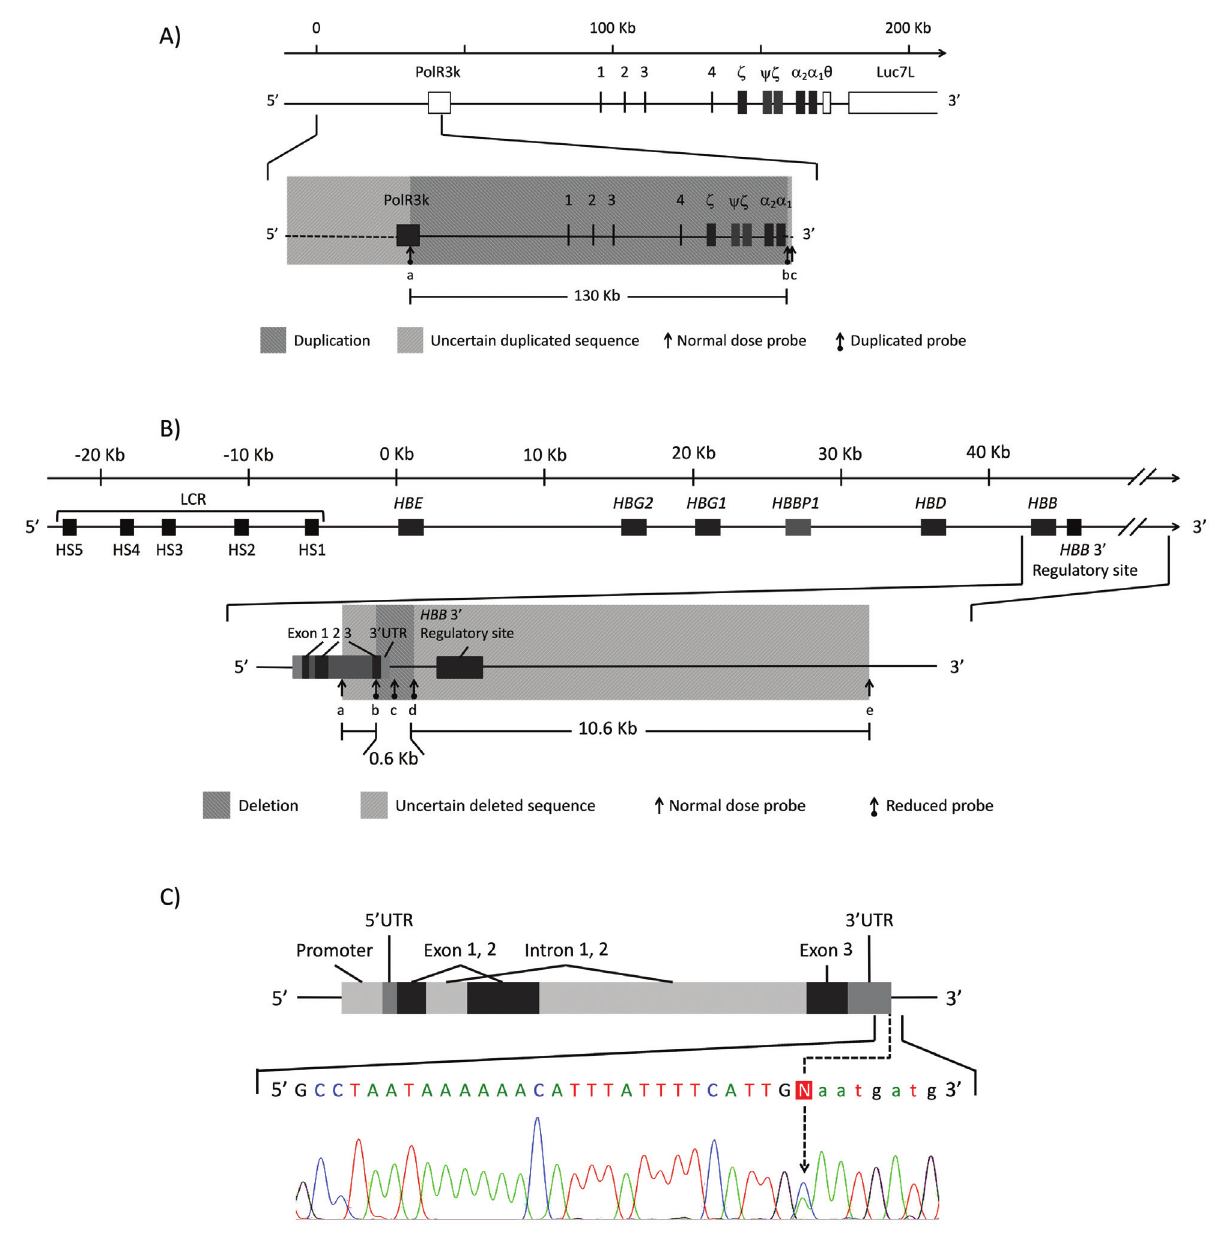
Figure 1 - Schematic representation of three globin gene mutations associated with HBB .c:118C > T in patients with (cid:2) -thal intermedia. A) (cid:3) -cluster du- plication from Family 1. Duplication is shown in dark grey shade, uncertain breakpoints are indicated in light grey shade; MCS-R sequences are num- bered from 1-4; involved MLPA probes are specified by (a) 463 bp 19236-L25316, (b) 283 bp 04638-L23602, and (c) 310 bp 04639-L04020. B) HBB 3’ deletion from Family 2. Deletion is indicated in dark grey shade, uncertain breakpoints are shown in light grey shade involved MLPA probes are pre- sented by (a) 196 bp 05833-L05335, (b), 166 bp 11884-L12684 (c) 206 bp 11885-L13080, (d) 173 bp 05836-L06321; (e) 274 bp 11980-L12803. C) HBB:c.*132C > A point mutation found in Family 3. Nucleotide change is indicated with an arrow. Nucleotides in capital letters represent transcribing